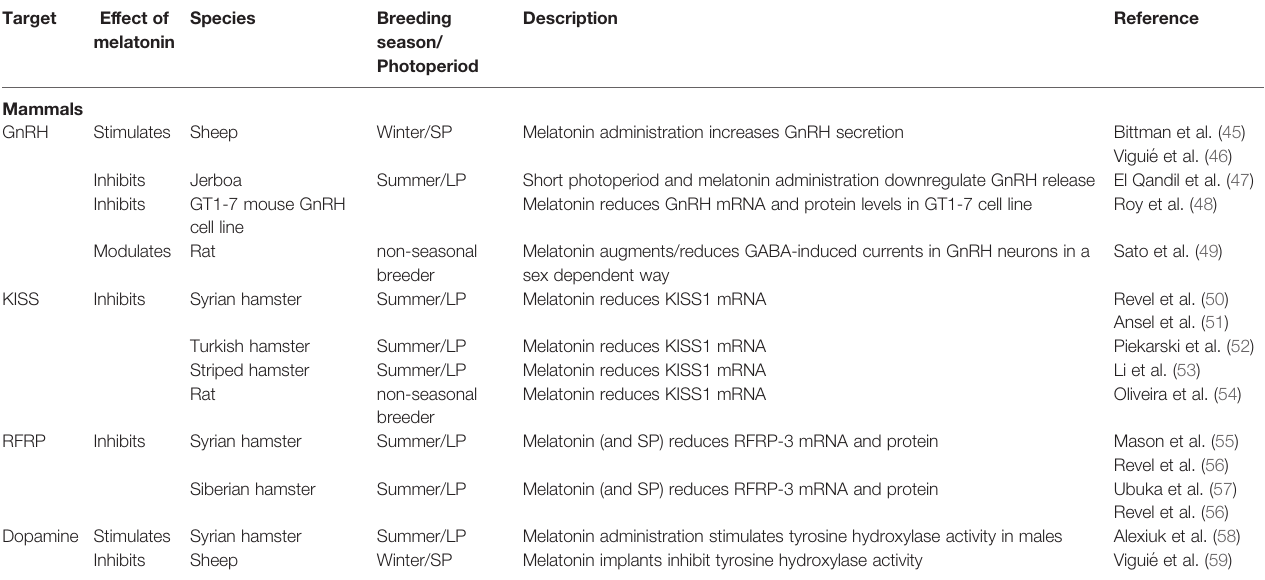
TABLE 1 | Summary of the known effects of melatonin POA/hypothalamic neurons controlling pituitary hormonal production in mammals.